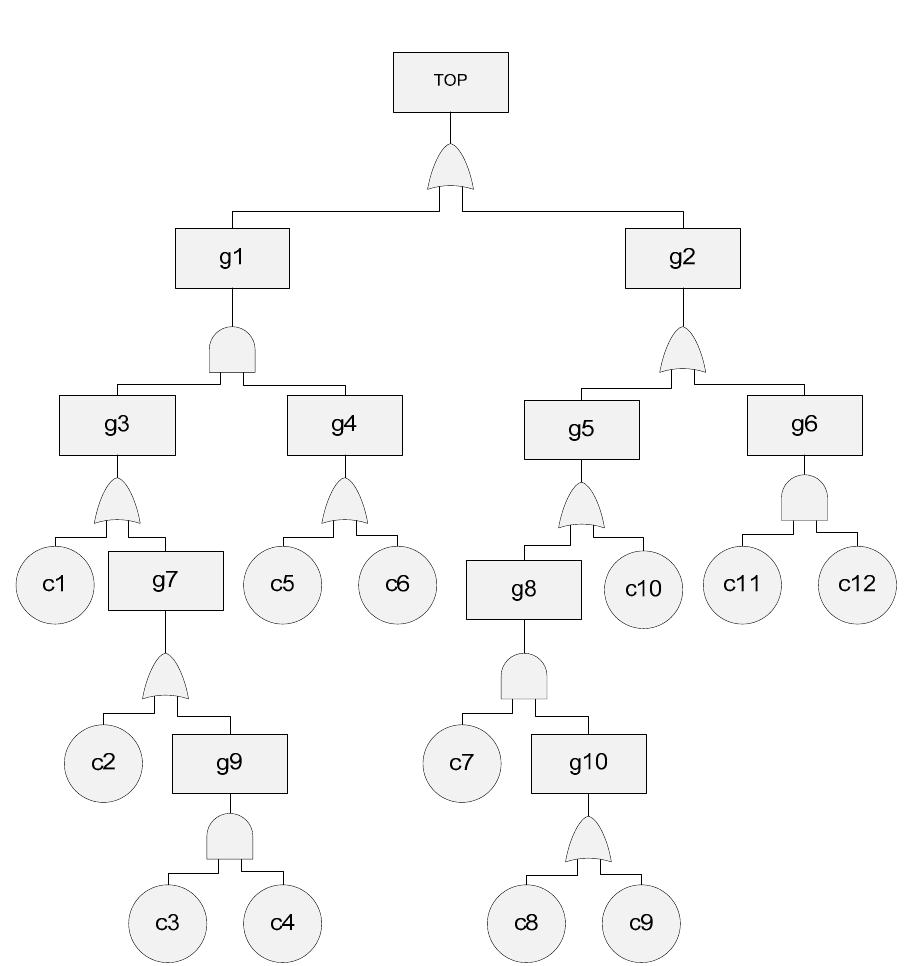
Figure 2. Fault tree example for a wind turbine (WT) (based on [37]).